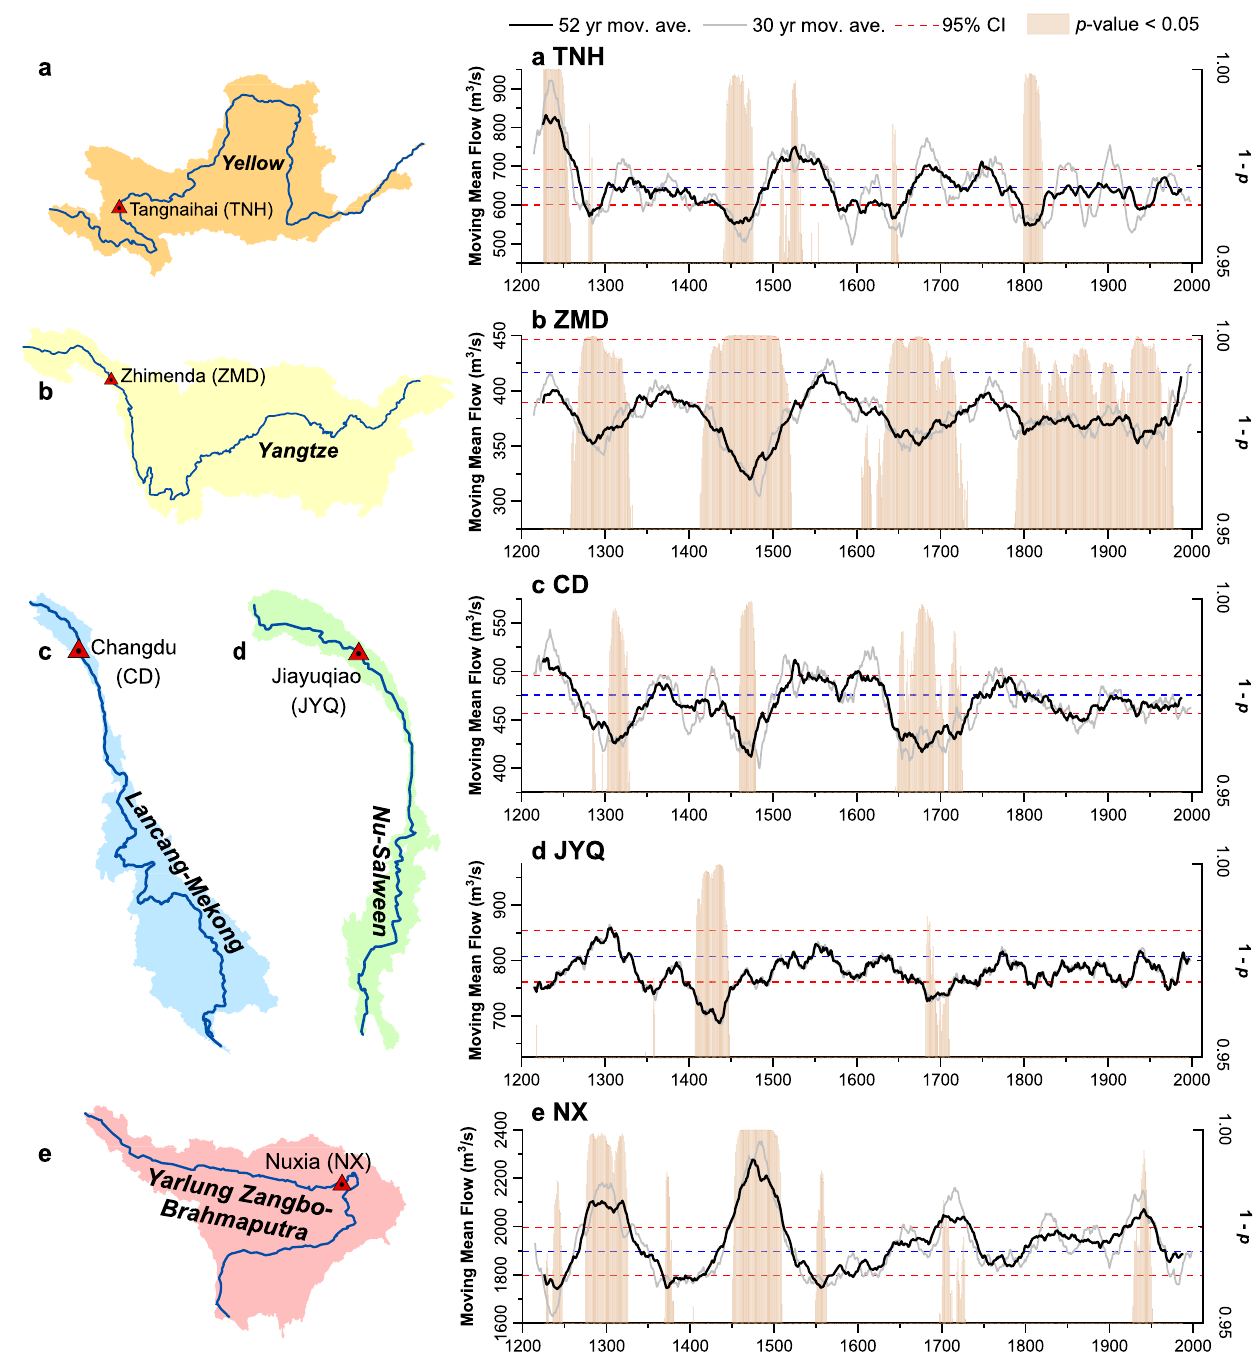
Fig.3|Reconstructedstream fl owtimeseriesbasedonbackwardmovingmean for the fi ve gauging stations in headwater regions of majorrivers in the South and East Tibetan Plateau (SETP). a Tangnaihai (TNH, Yellow); b Zhimenda (ZMD, Yangtze); c Changdu (CD, Lancang-Mekong); d Jiayuqiao (JYQ, Nu-Salween); and e Nuxia (NX, Yarlung Zangbo-Brahmaputra). Black lines for all gauging stations represent time series of 52-year (33-year for JYQ) moving means for annual stream fl ow reconstructions. Grey lines represent 30-year moving averages. Buff